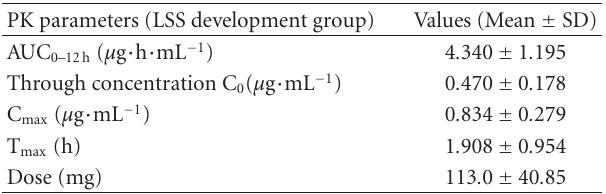
Table 2: Pharmacokinetic parameters (PK) in allogenic hemato- poitic stem cell transplantation.